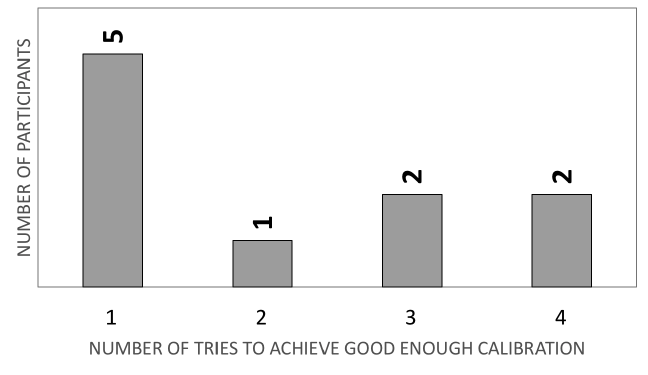
Figure 15. Distribution of participants according to the number of eye tracking calibration tries required to achieve a good enough